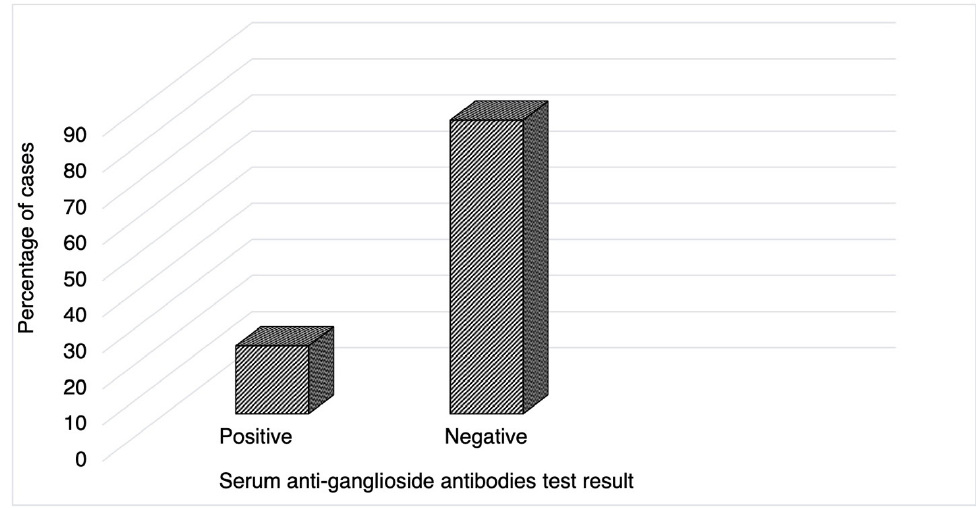
Figure 1. Serum anti-ganglioside antibodies test result.